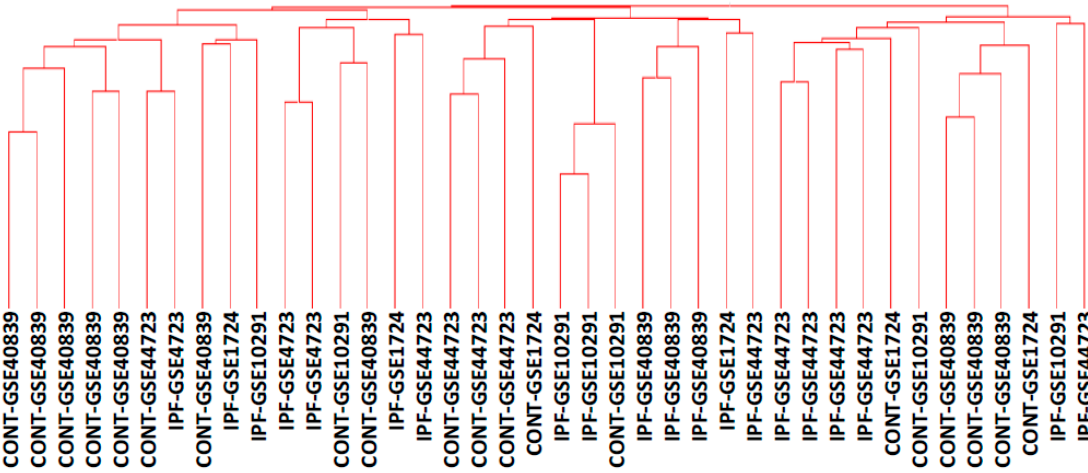
Figure 3. Unsupervised clustering of fibroblast cultures based on the full 17,414 genes list. The dendrogram results from Unweighted Pair Group Method with Arithmetic Mean (UPGMA) hierarchical clustering using all 17,414 genes in the dataset, using Pearson’s correlation as the similarity measure. Samples are identified as either Control (CONT) or IPF, followed by their dataset of origin.